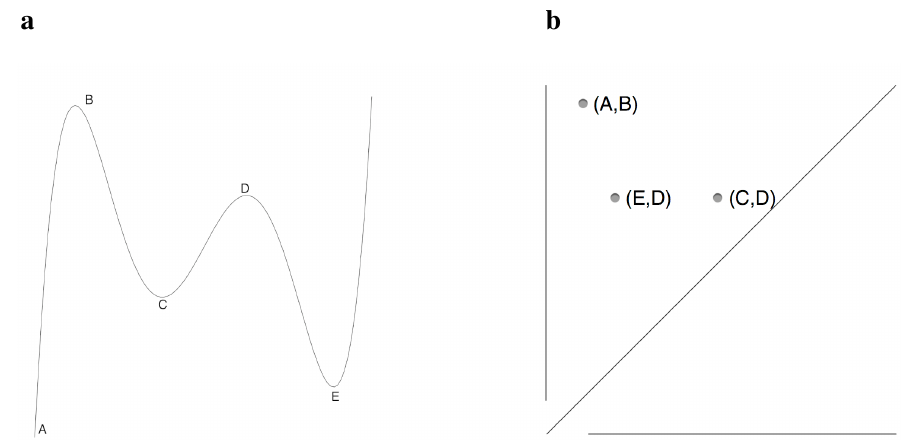
Figure 1. Illustration of computation of persistence diagrams. ( a ) There is an example of a one-dimensional surface. The zero dimensional persistence pairs of the function on the left are (A,B), (C,D), and (E,D). The first point represents the place where an island forms. The second point is the place where it is completely flooded. ( b ) The persistence diagram is obtained by plotting the birth and death height of each island. The difference between y and x coordinates is the life span of an